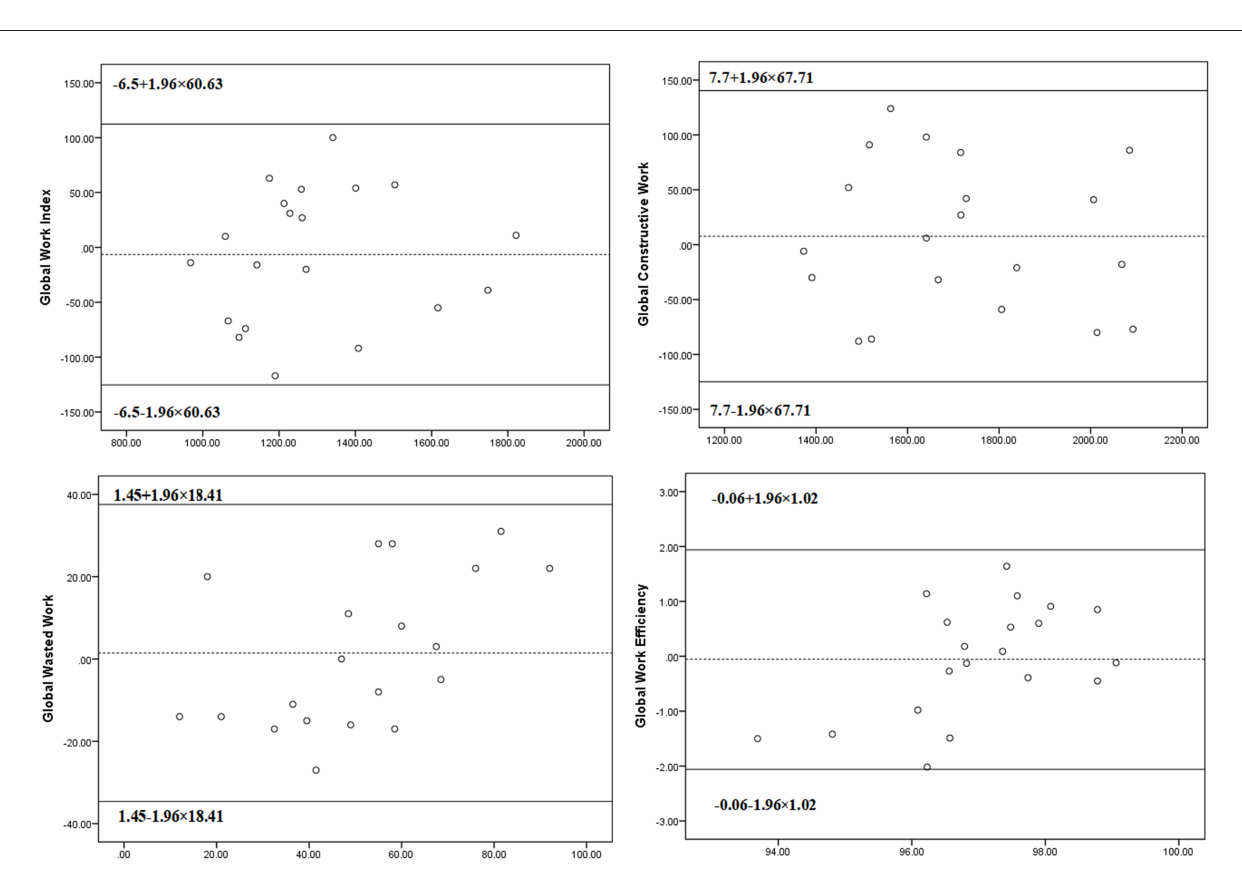
(94–97)%, respectively (10). Morbach et al. (11) and Galli et al. (12) presented analyses on the reference values of healthy